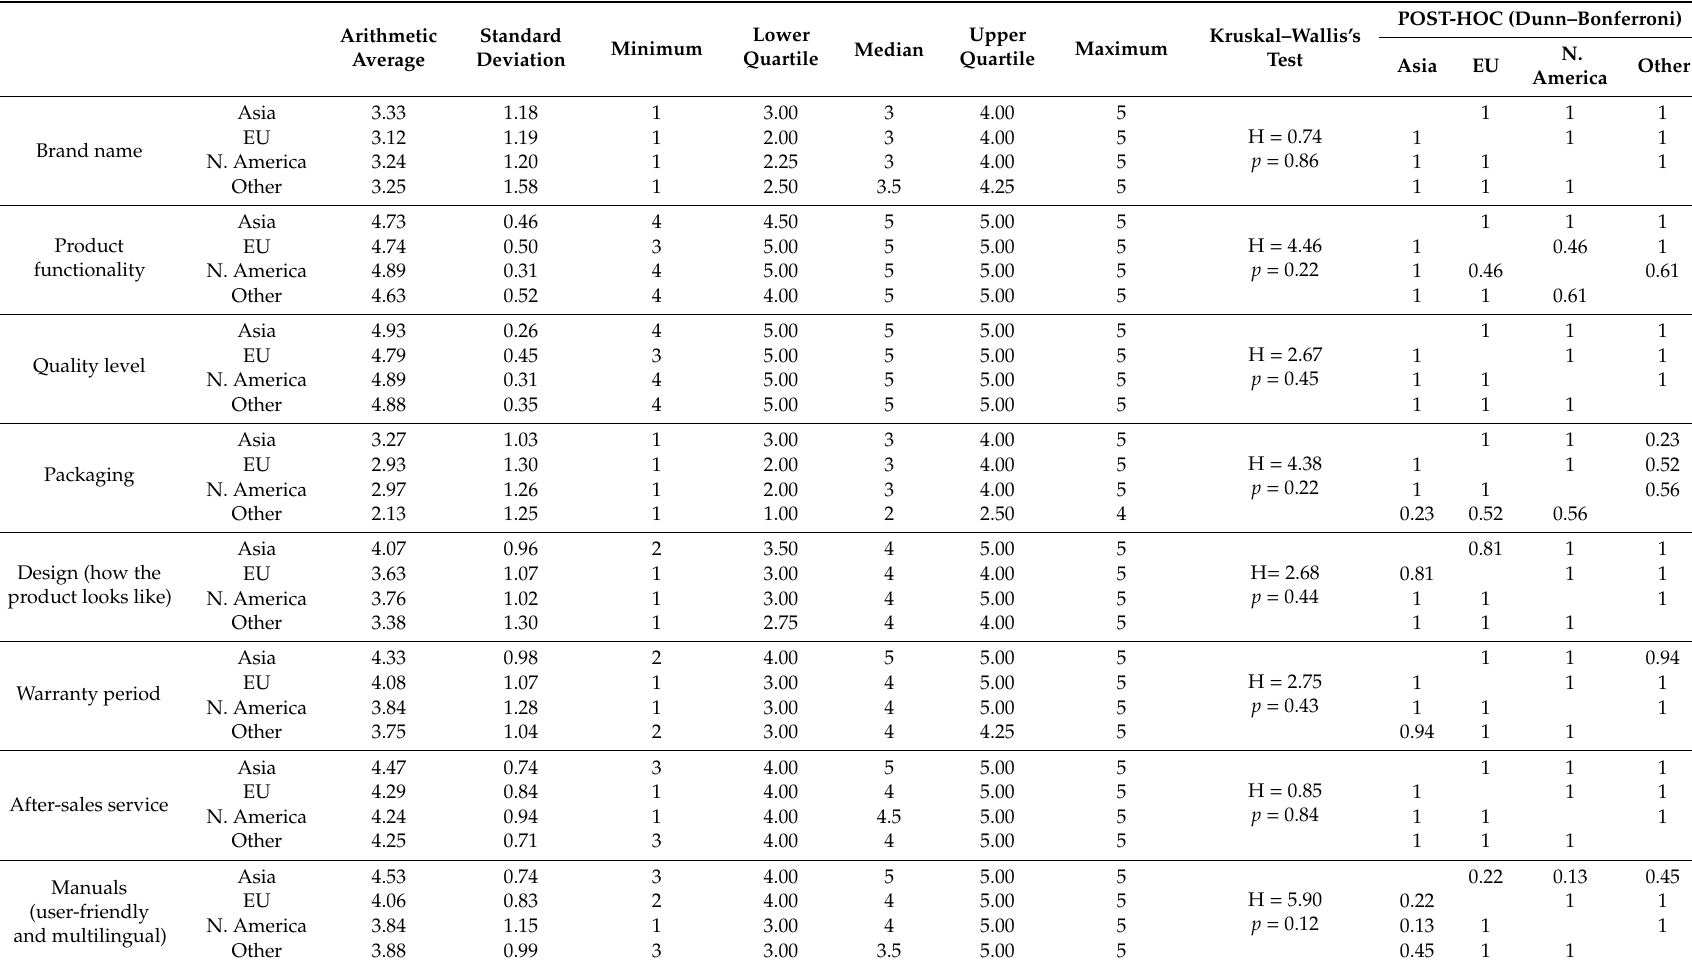
Table 2. Ratings of the scales “Rate each of the elements according to the importance” depending on the continent from which the value co-creator originates. Source: own elaboration ( n =